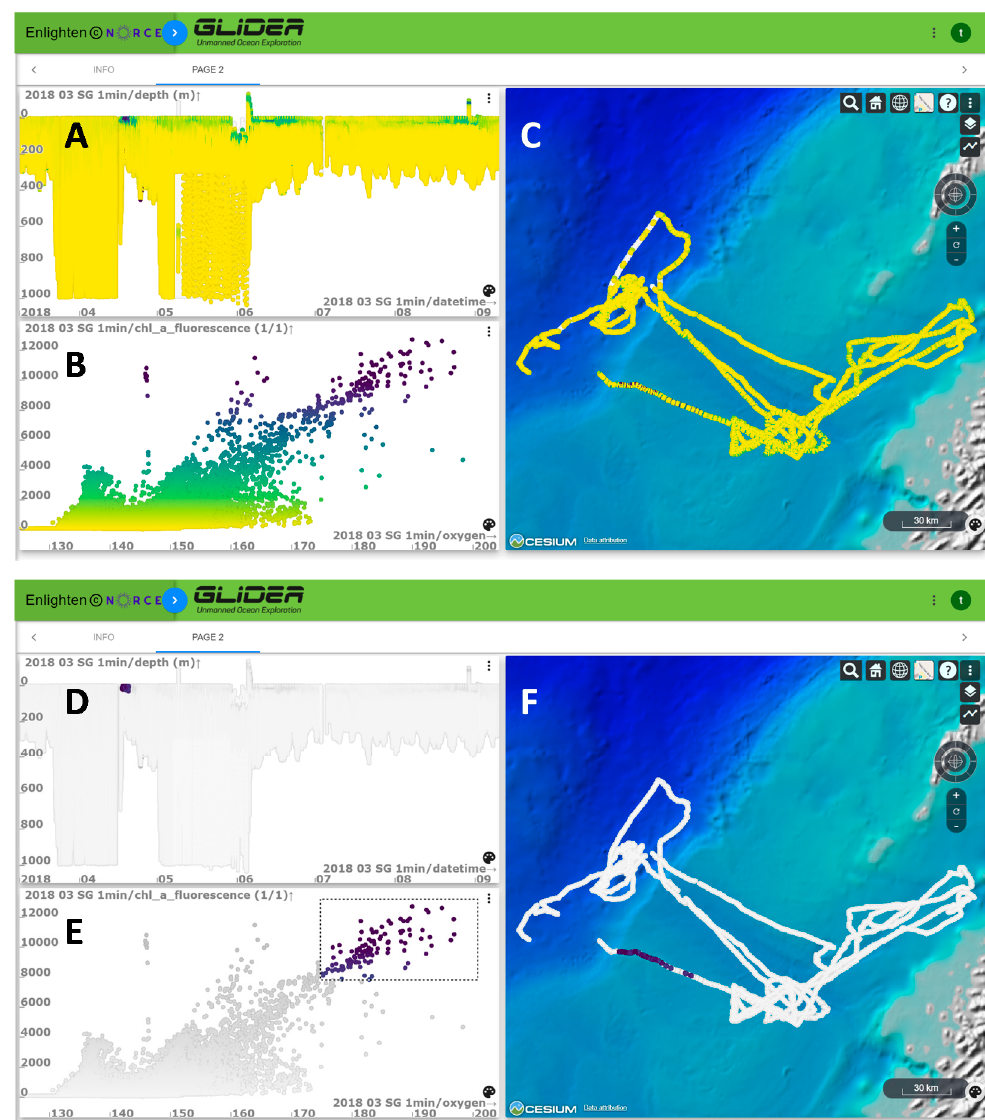
Figure 4. Example plots from the GLIDER web portal showing down-sampled data collected by the Seaglider ® in the 2018 survey. In all plots, color on data points corresponds to the level of chlorophyll-a (CHl-a, fluorescence). ( A ) Depth along the Seaglider ® path (x-axis is time, y-axis is depth). ( B ) Correlation between oxygen (x-axis) and CHl-a (y-axis). ( C ) Path travelled by Seaglider ® for which data are displayed. Bottom panel shows the depth ( D ) and CHl-a-oxygen correlation ( E ) along the Seaglider ® path ( F ) after the user applied a filter highlighting high CHl-a and oxygen values.